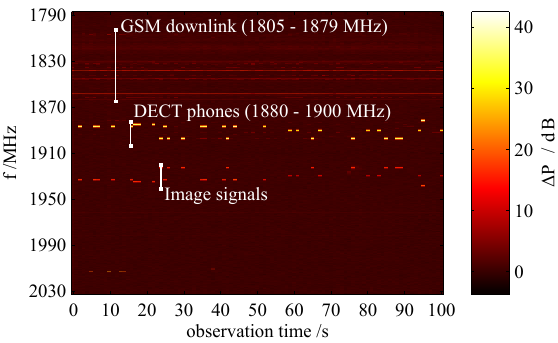
contains two known signals which apply frequency hopping; Global System for Mobile communication (GSM) downlink and Digital Enhanced Cordless Telecommunications (DECT) signals. GSM downlink signals apply frequency hopping with time slots equal to 576.9 µ s according to [22]. DECT phone signals in the band from 1880 to 1900 MHz have 5 ms frames [23]. Fig. 19 shows the spectrogram that is displayed real time from the FPGA calculation.